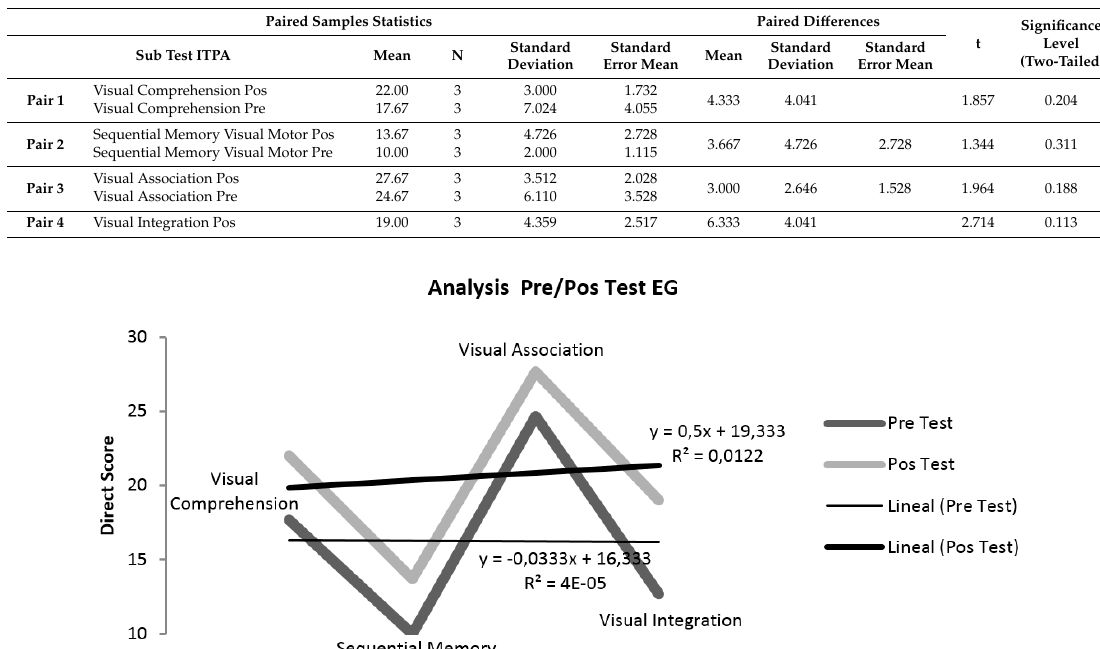
Table 5. Central tendency statistics and relational T-Student in EG for ITPA.